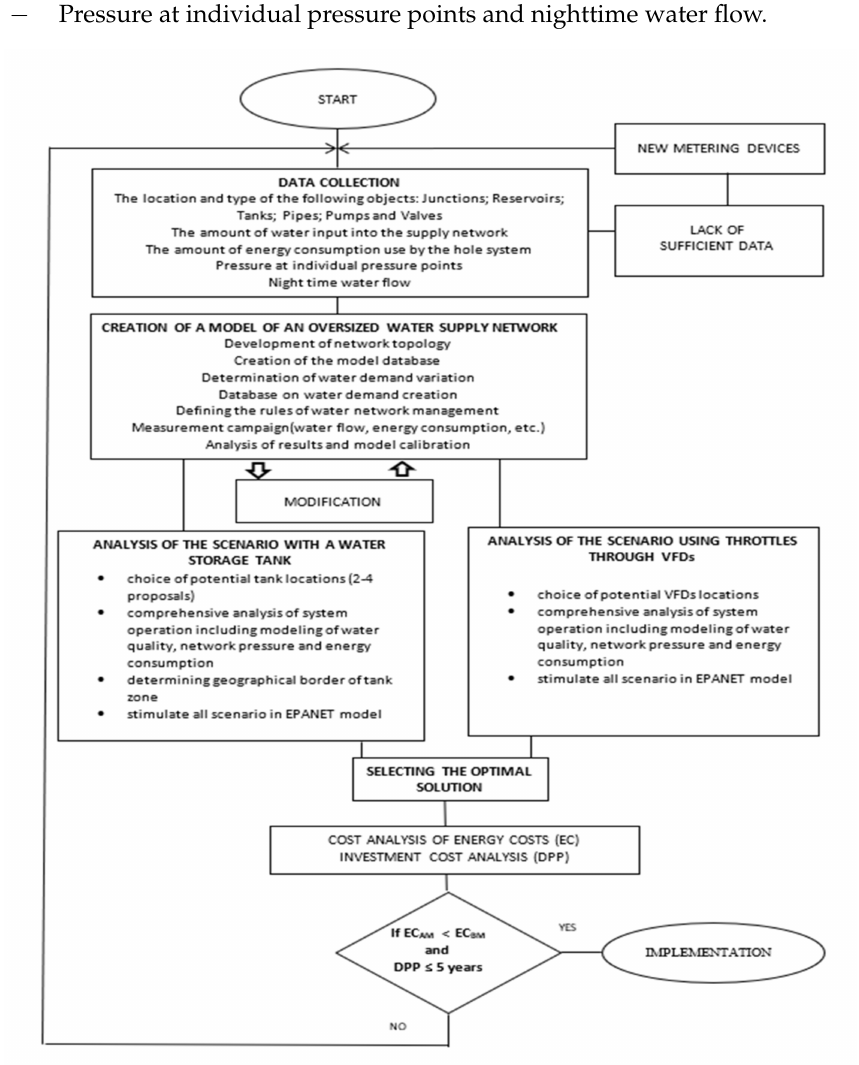
Figure 9. Flowchart of a comprehensive analysis of hydraulic and energy efficiency management and making rational decisions in oversized water supply systems (EC AM —energy costs after mod- ernization; EC BM —energy costs before modernization; DPP—discounted payback